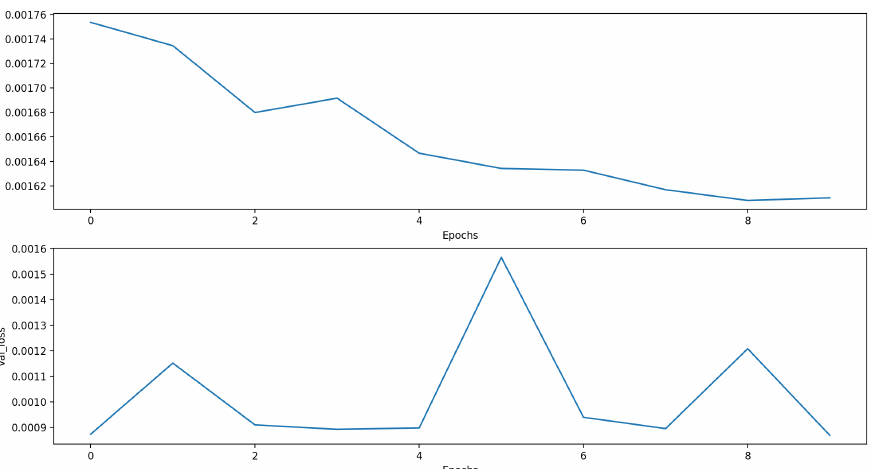
Figure 6. Train and validation MSE of the LSTM + Dense model with the best forecasting performance with the 24 h time horizon.